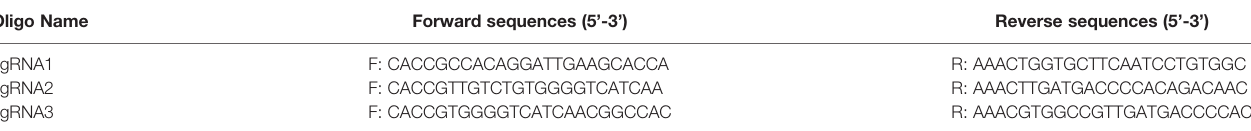
TABLE 2 | CRISPR/Cas9 sgRNA oligo